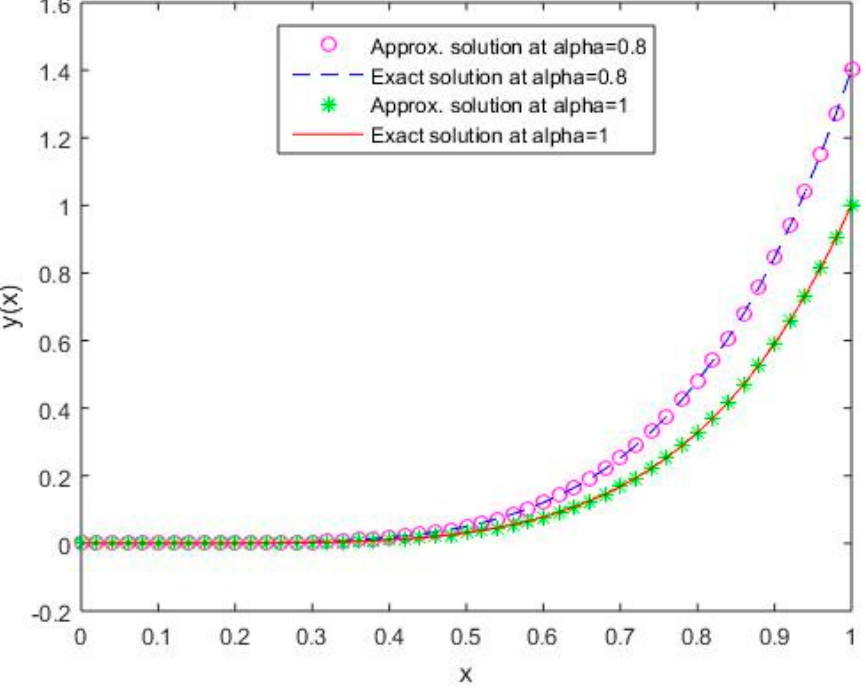
Figure 5. Comparison of exact and numerical solutions using S5 for 𝛼 = 0.8 and 𝛼 = 1 , Example 1.